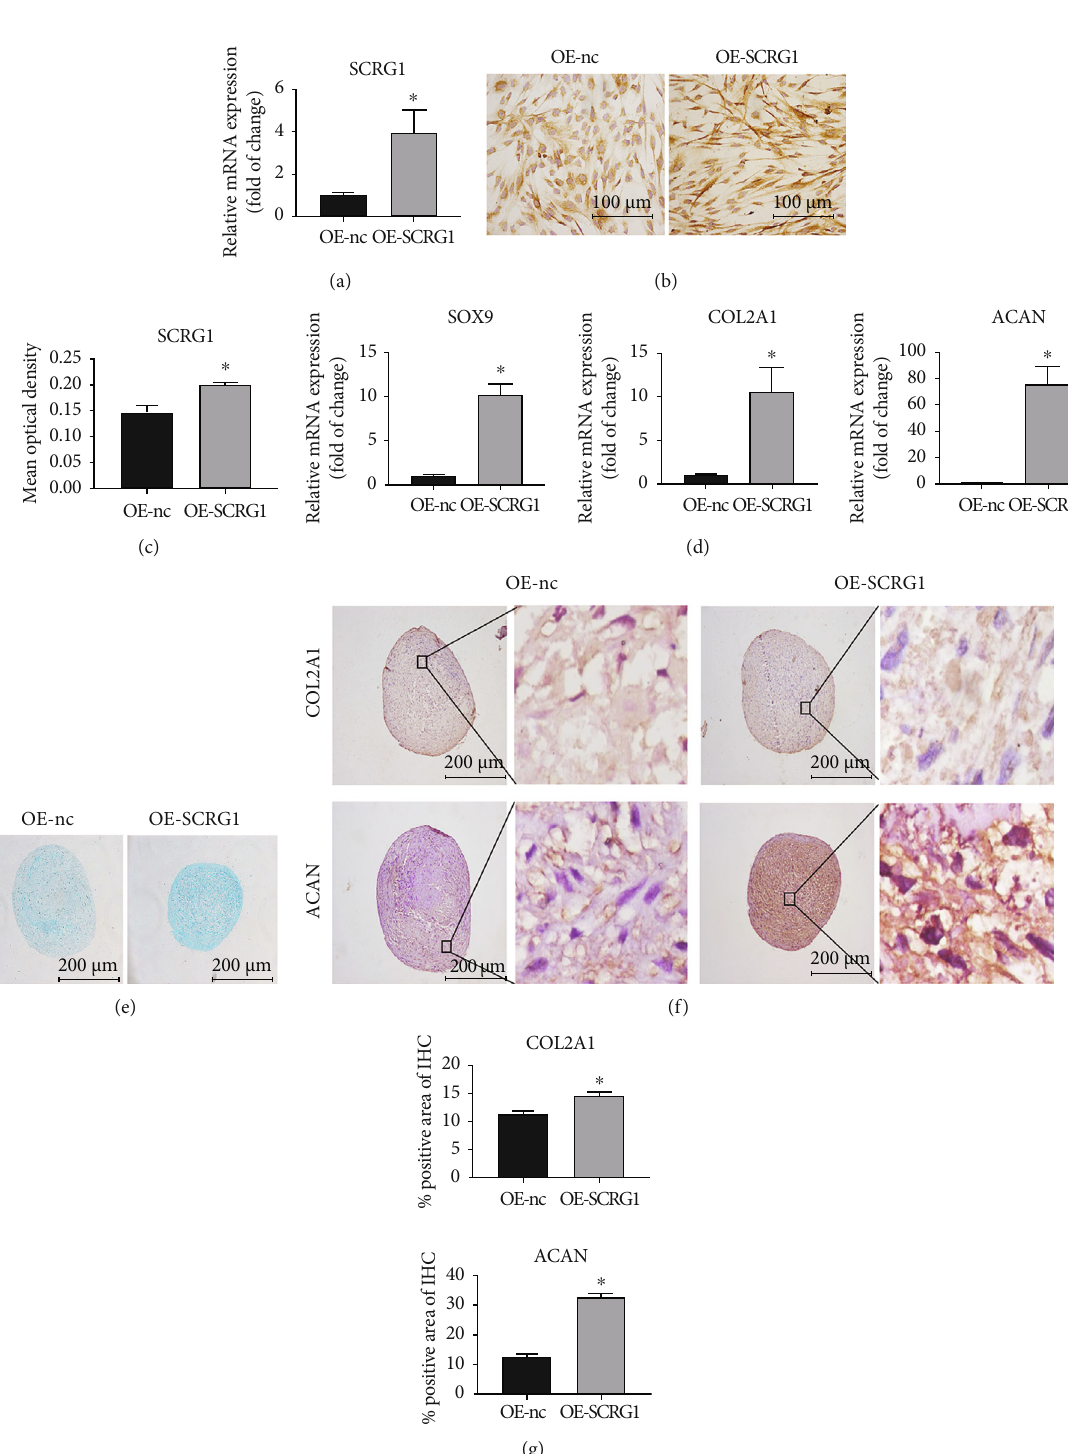
Figure 4: SCRG1 overexpression promoted chondrogenic di ff erentiation of UCMSCs. (a – c) mRNA and protein levels of SCRG1 were detected by qRT-PCR and IHC. Results showed that mRNA and protein levels of SCRG1 increased after overexpression of SCRG1. Scale bar = 100 μ m . (d) SOX9 , COL2A1 , and ACAN mRNA levels increased after overexpression of SCRG1. (e) Alcian Blue staining showed an increase in glycosaminoglycans at day 21 after overexpression of SCRG1. Scale bar = 200 μ m . (f, g) Protein levels of COL2A1 and ACAN detected by IHC at day 21 increased after SCRG1 knockdown. Scale bar = 200 μ m . Experiments were repeated three times; ∗ P < 0 : 05 ( t